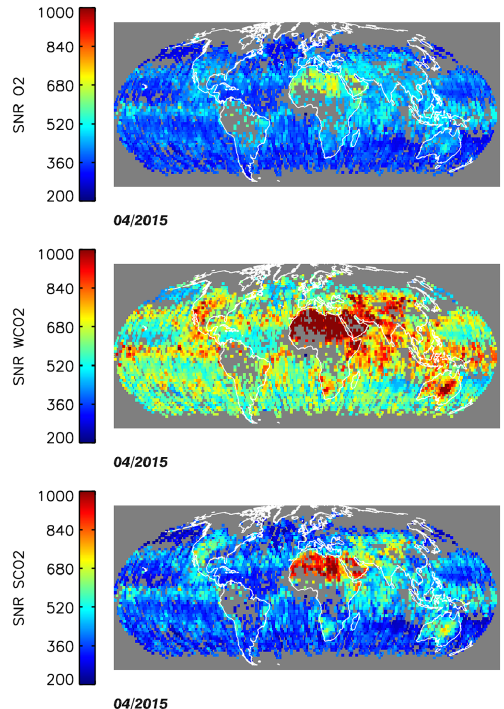
Figure 6. Maps of the continuum signal-to-noise ratio for the three bands of the OCO-2 instrument in April 2015. Statistics are pro- vided for 2 ◦ by 2 ◦ bins for data selected with the data quality